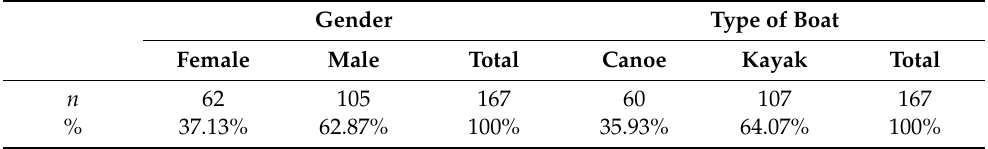
Table 1. Participation canoe-kayak in the ‘L Winter Championship Seville 2019’.